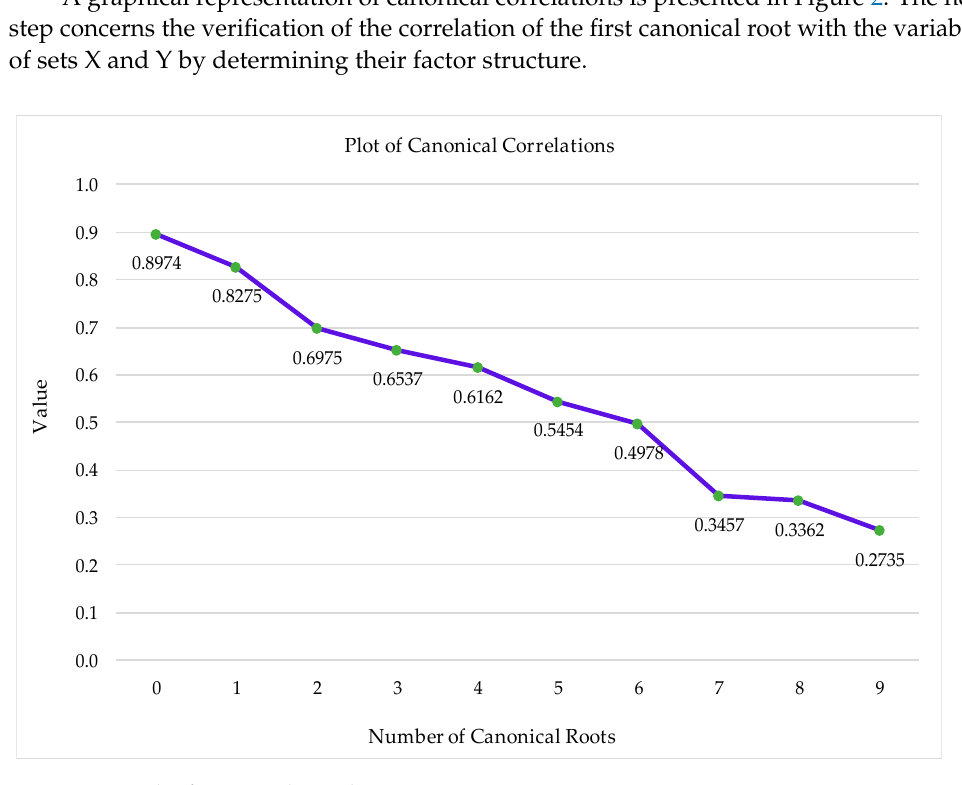
Figure 2. Graph of canonical correlations.